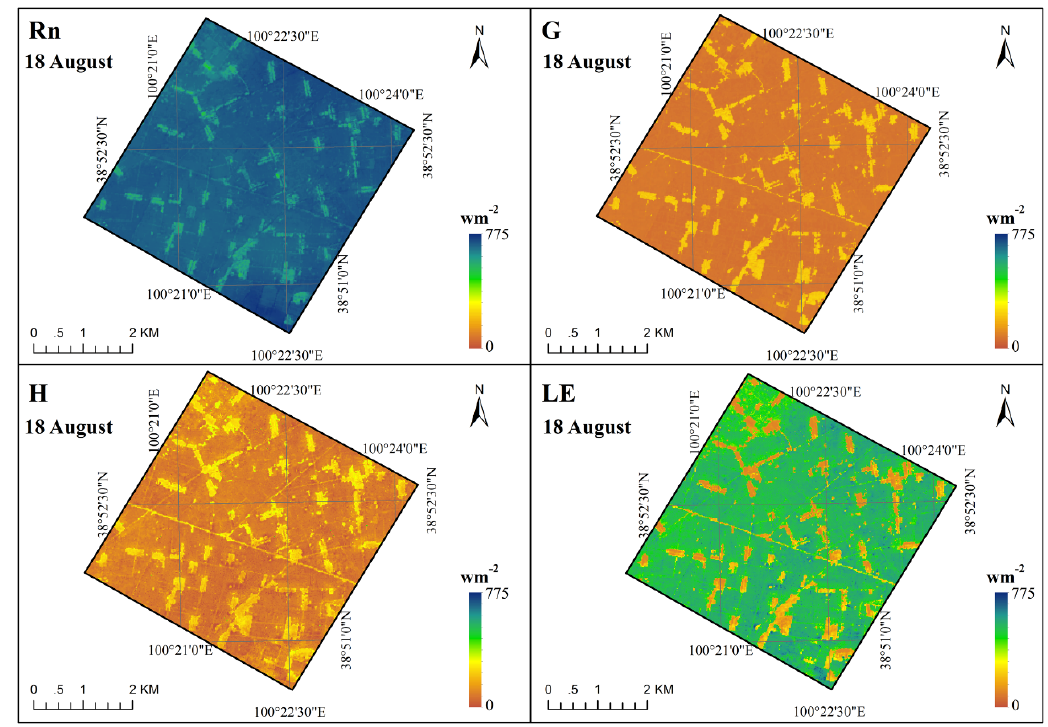
Figure 4. Maps of the improved TSEB-derived surface energy fluxes on 18 August 2012. Table 1. Statistics of the improved TSEB model-derived surface energy fluxes.